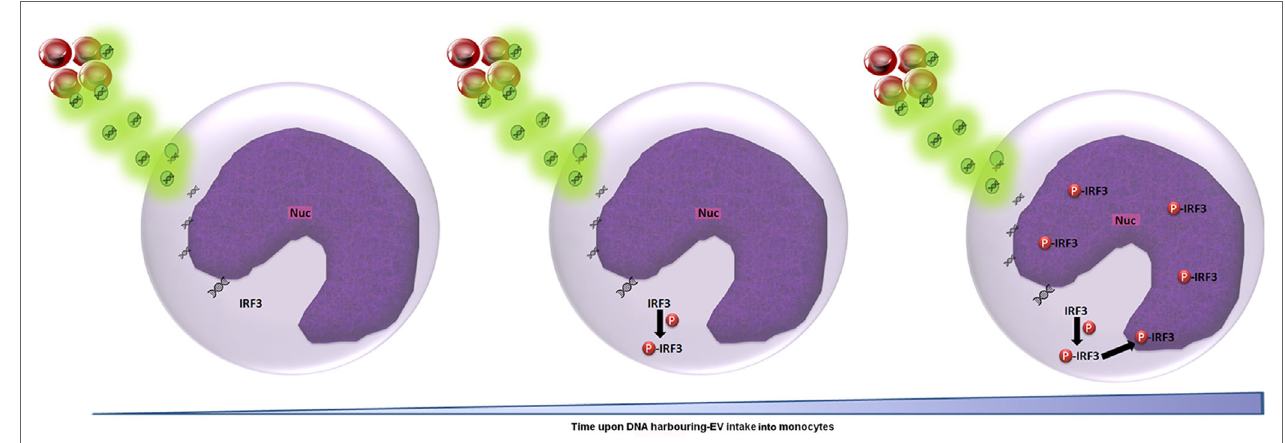
FIgURe 6 | Schematic representation of the cascade of events upon Plasmodium falciparum ( Pf )-gDNA intake by host monocytes. In non-activated monocytes, transcription factor IRF3 is localized in the cytoplasm. Upon Pf , DNA cargo internalization into the cytoplasm, IRF3 undergoes phosphorylation and is translocated into the nucleus to induce the cellular immune response (from left to right). Abbreviation: Nuc, nucleus.